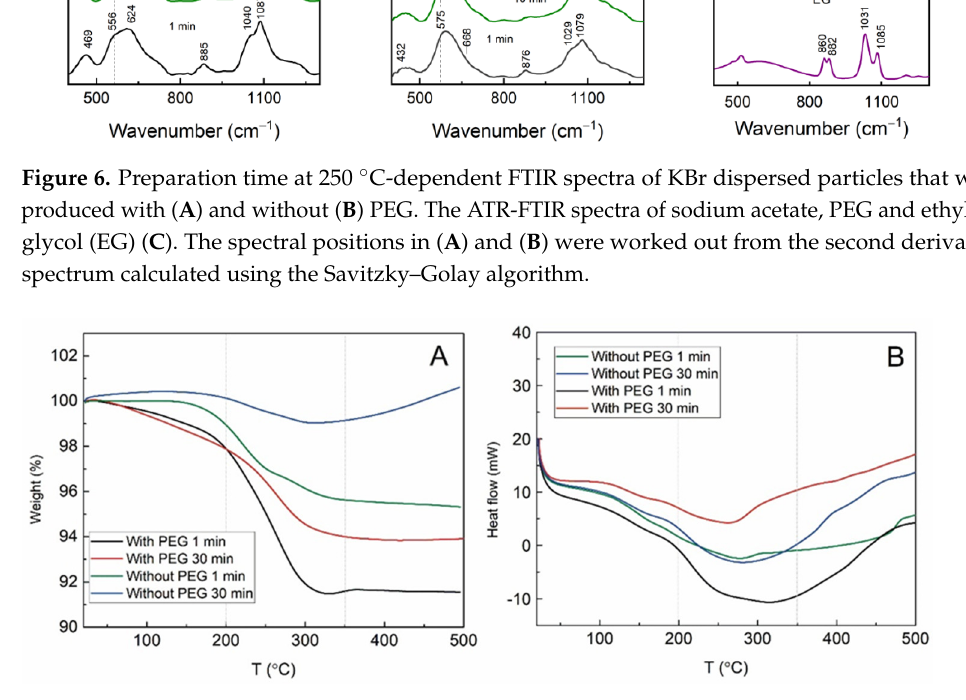
Figure 7. TGA data of samples synthesized with PEG and without PEG; synthesis time—1 or 30 min at 250 °C. Changes in sample weight ( A ) and heat flow ( B ) are registered from room temperature to 500 °C.